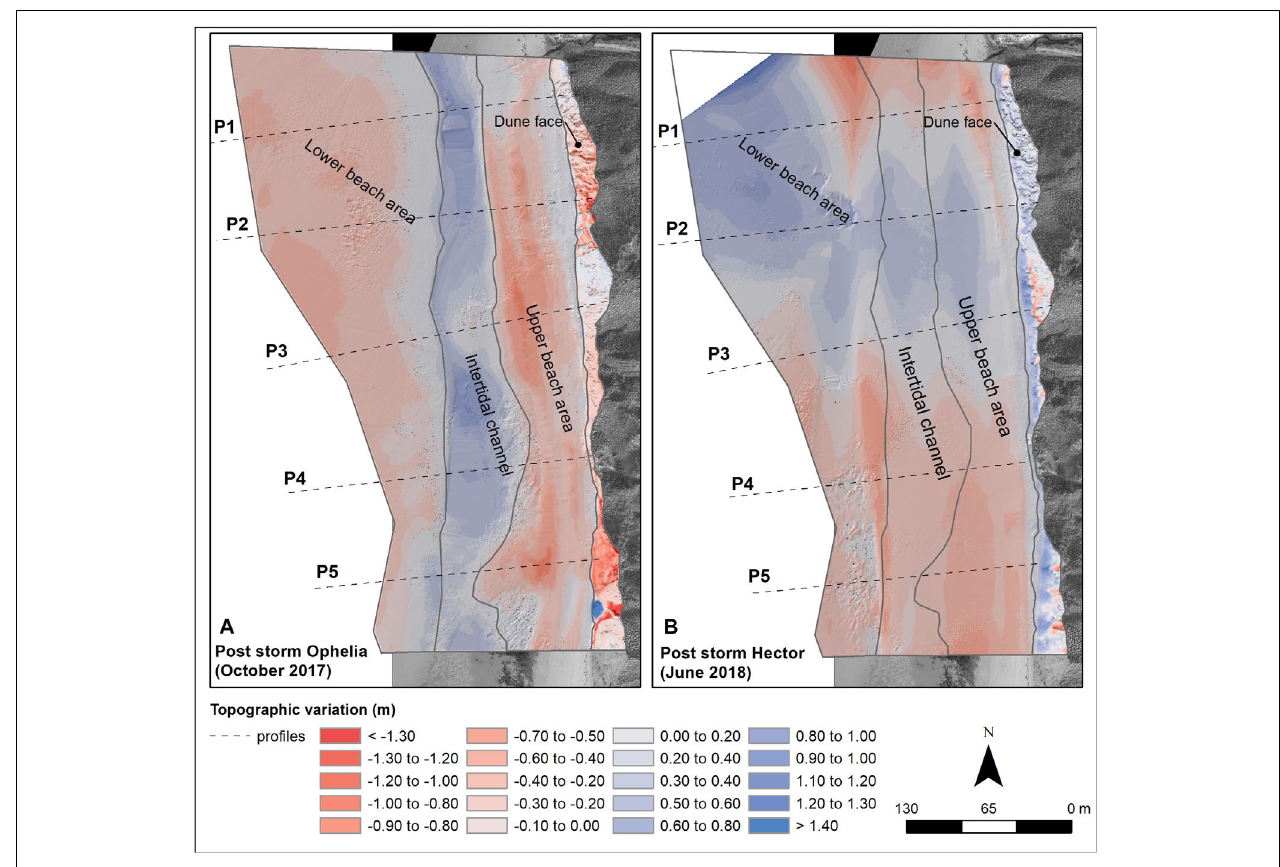
FIGURE 7 | Spatial representation of topographic changes measured pre- and post-Storm Ophelia (A) and Storm Hector (B) at the study site. Four zones (dune face, upper beach, intertidal channel and lower beach area) are defined where topographic changes are evident. Note that cross-shore profiles are represented with black dashed